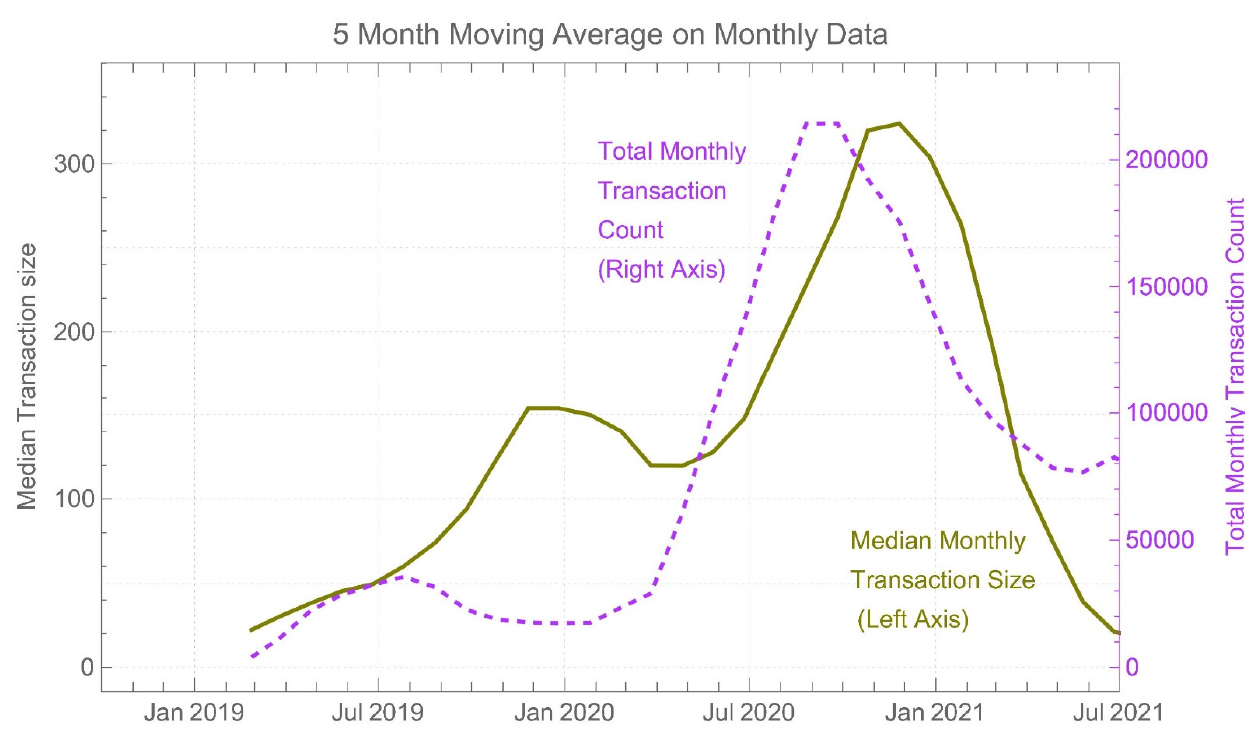
Figure 4. Monthly Transaction Count and Median Transaction Size.